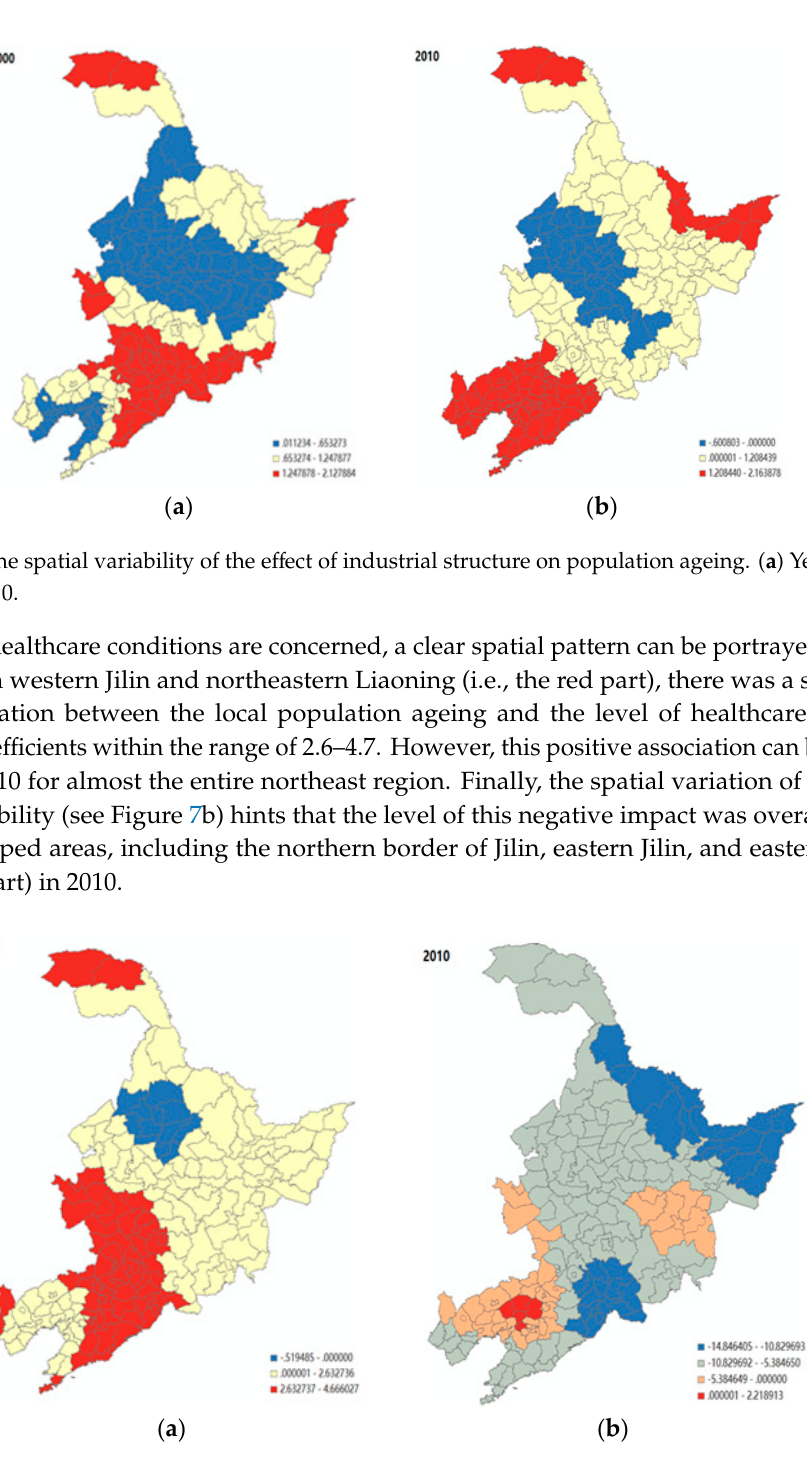
Figure 5. The spatial variability of the effect of mortality on population ageing. ( a ) Year 2000; ( b ) Year 2010.